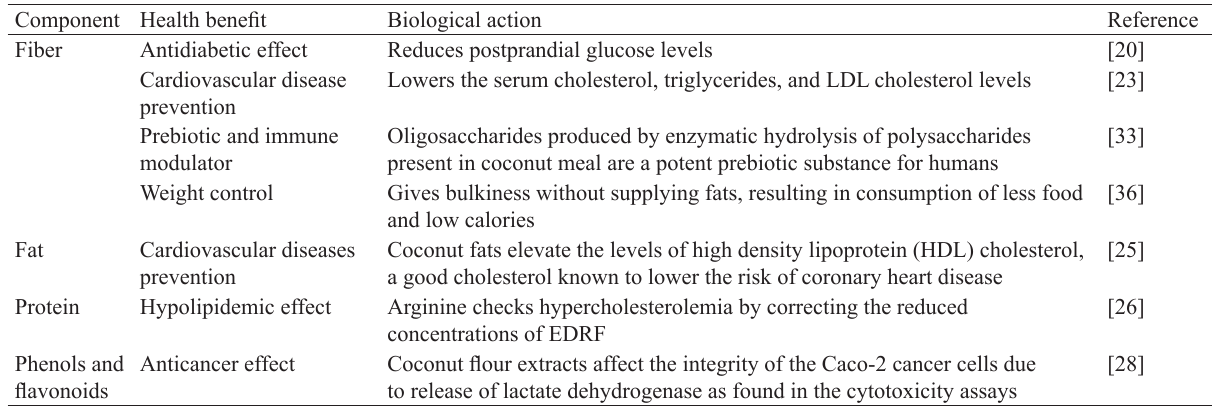
Table 2 Health benefits of coconut flour Component Health